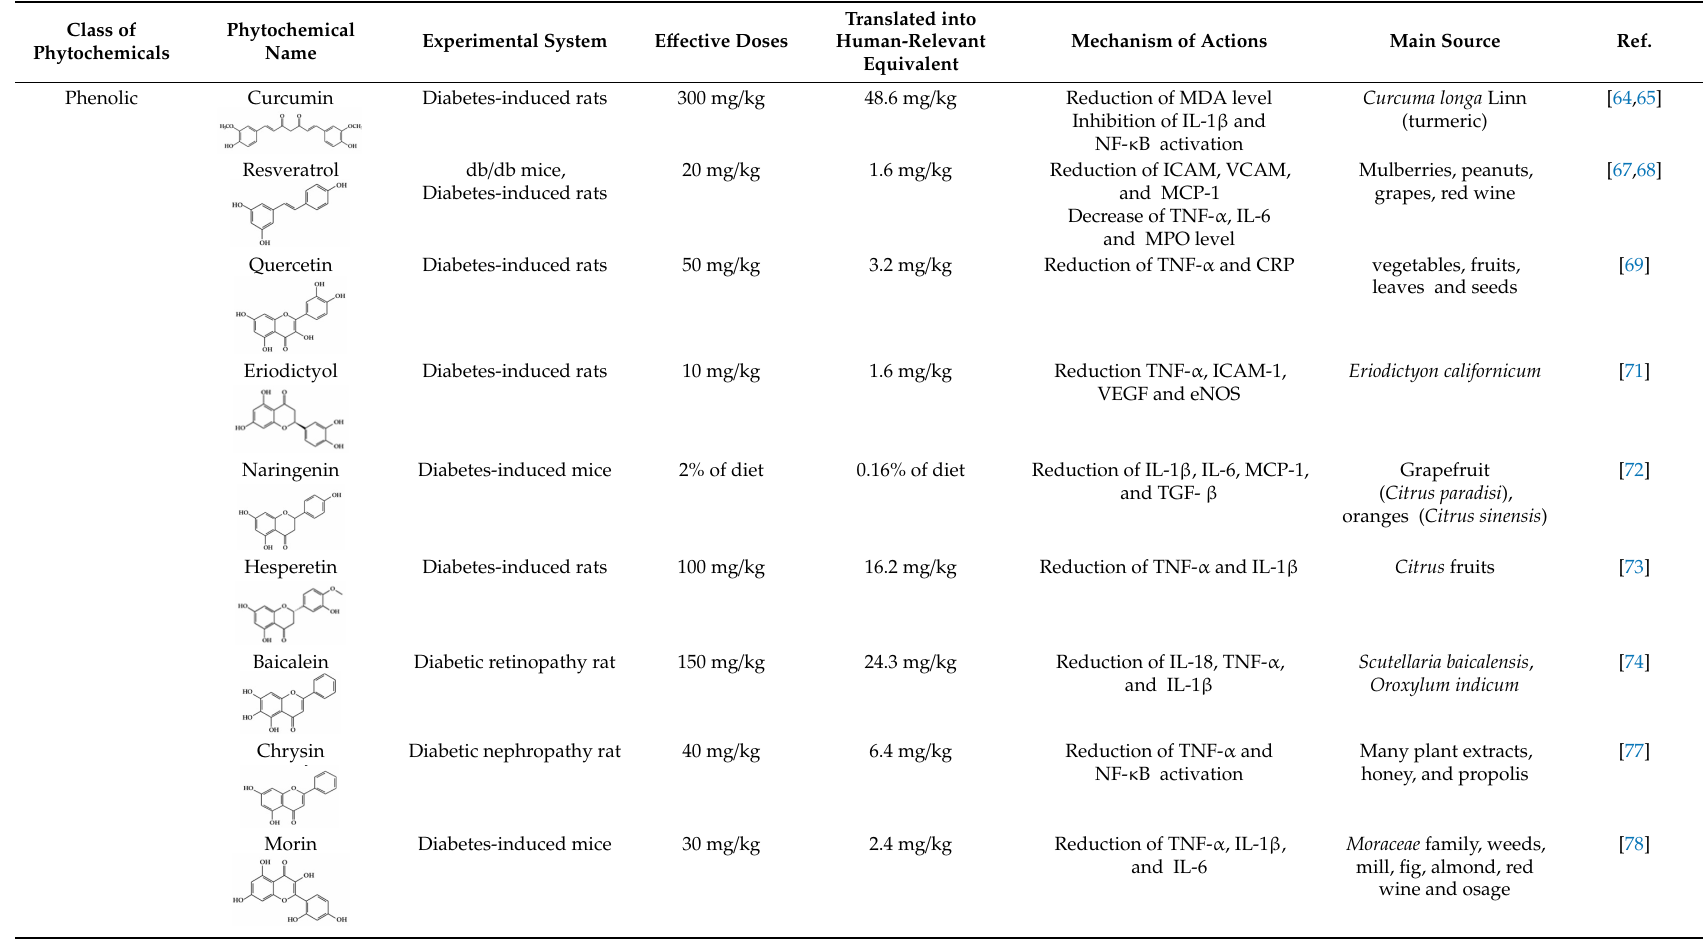
Table 2. Phytochemicals and their e ff ective mechanism in diabetes and